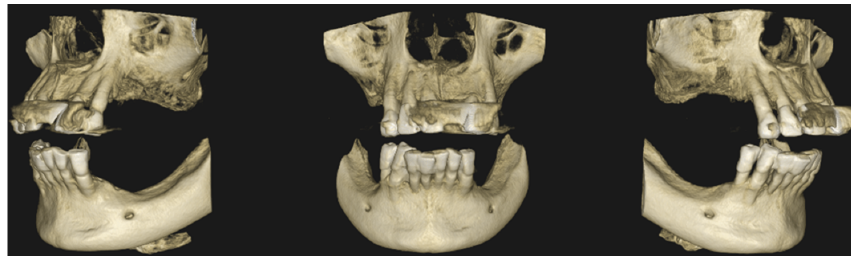
Figure 1. 3D reconstruction of the CBCT scan.